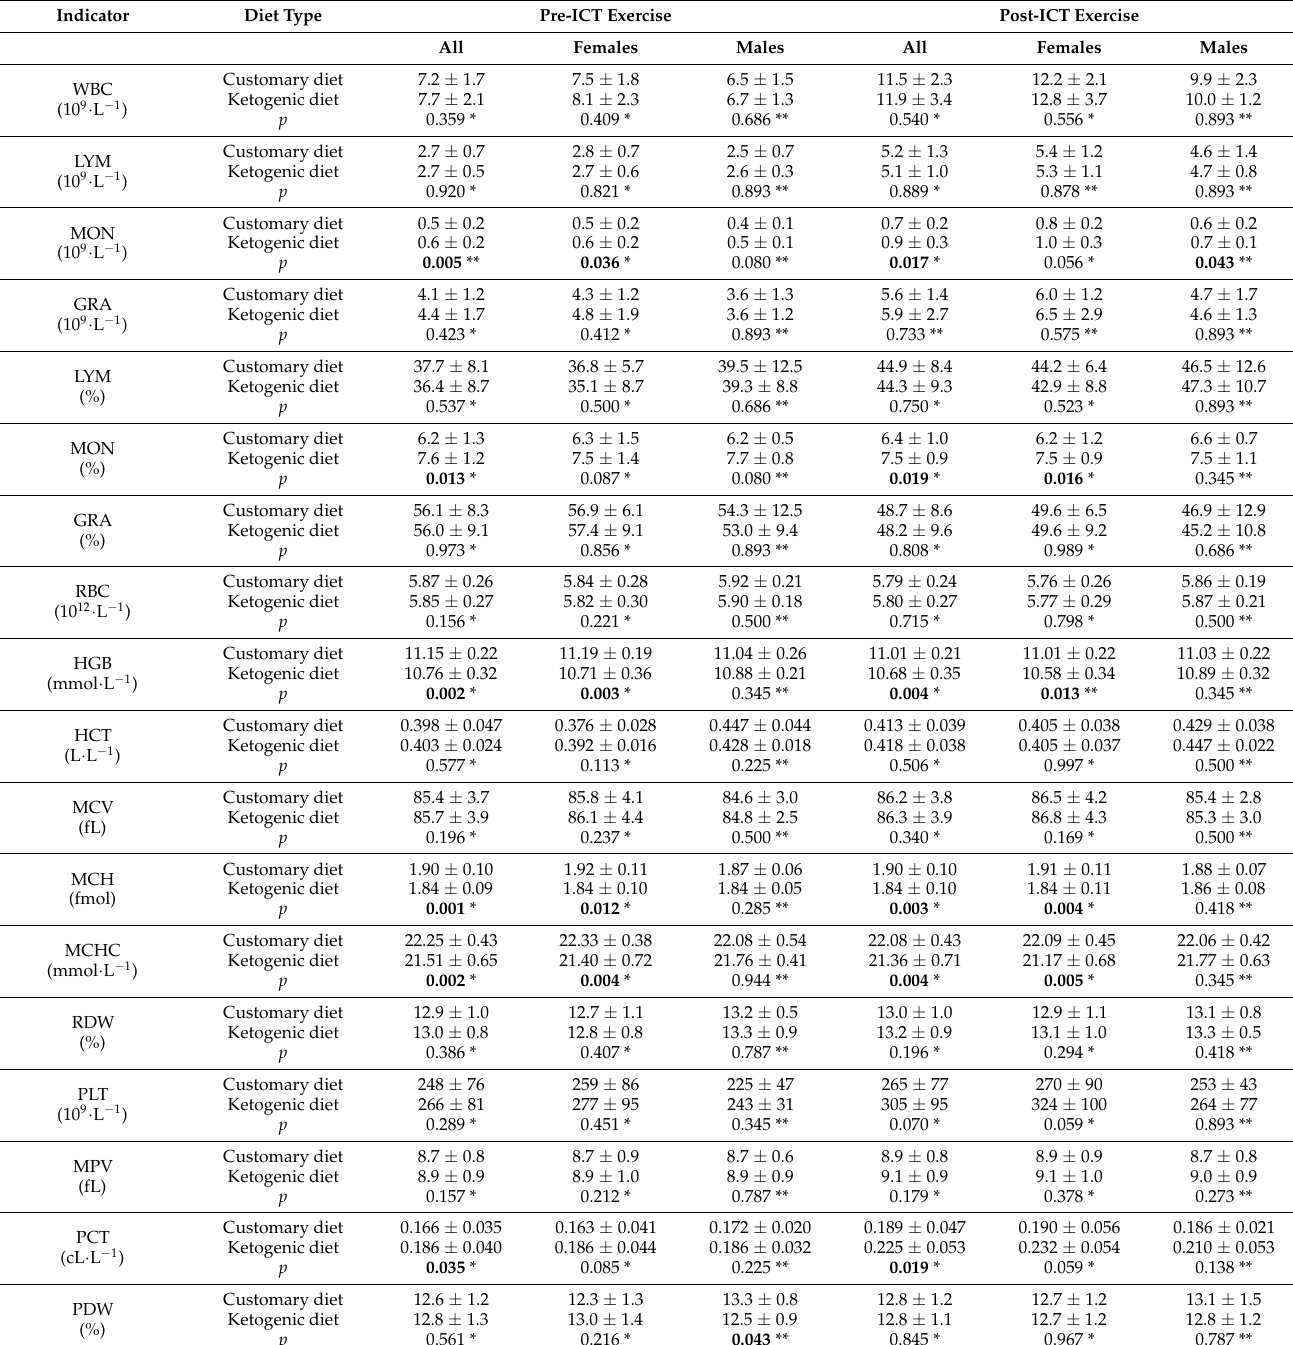
Table 5. Blood haematological